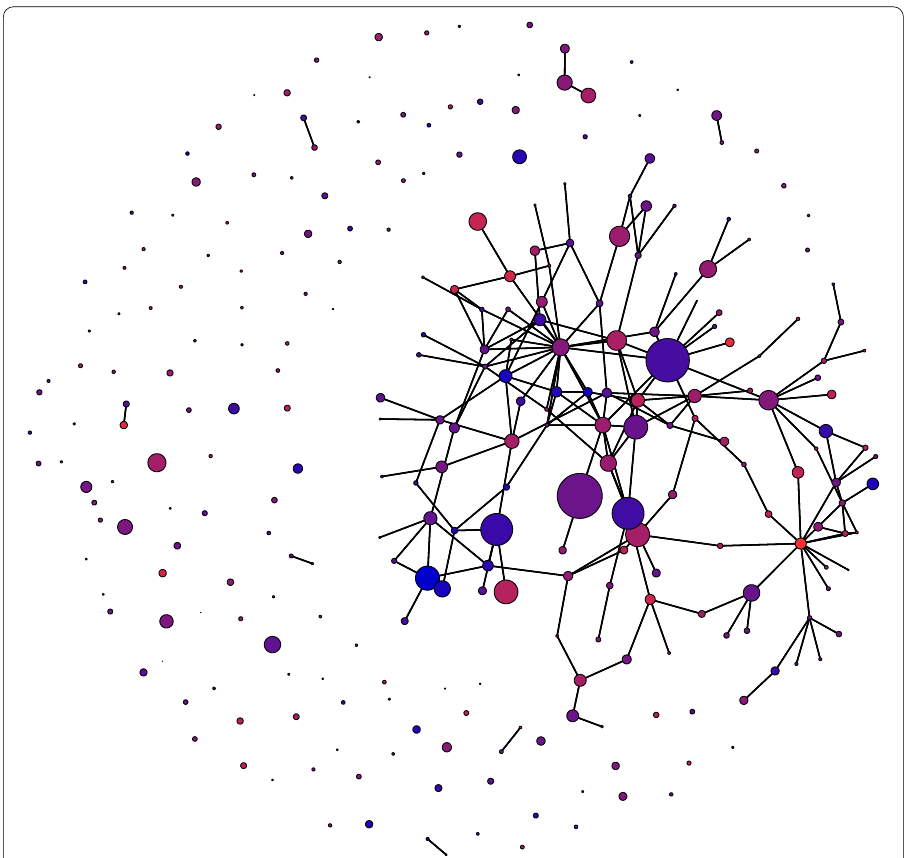
Fig. 3 Think tank board interlock network. Edges represent instances where the same individual served on the board of directors of two organization between 2008 and 2015. Node size is proportional to organizations’ average total revenue during this period, and color is a function of the organizations’ ideological ideal point (IGScore), where blue indicates more liberal and red indicates more conservative. The network is displayed using the Fruchterman and Reingold force-directed algorithm (Fruchterman and Reingold